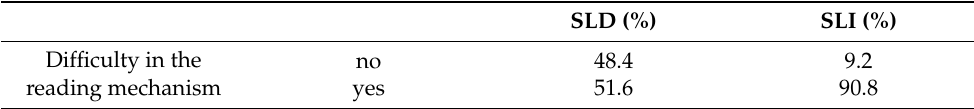
Table 4. Reading difficulties.